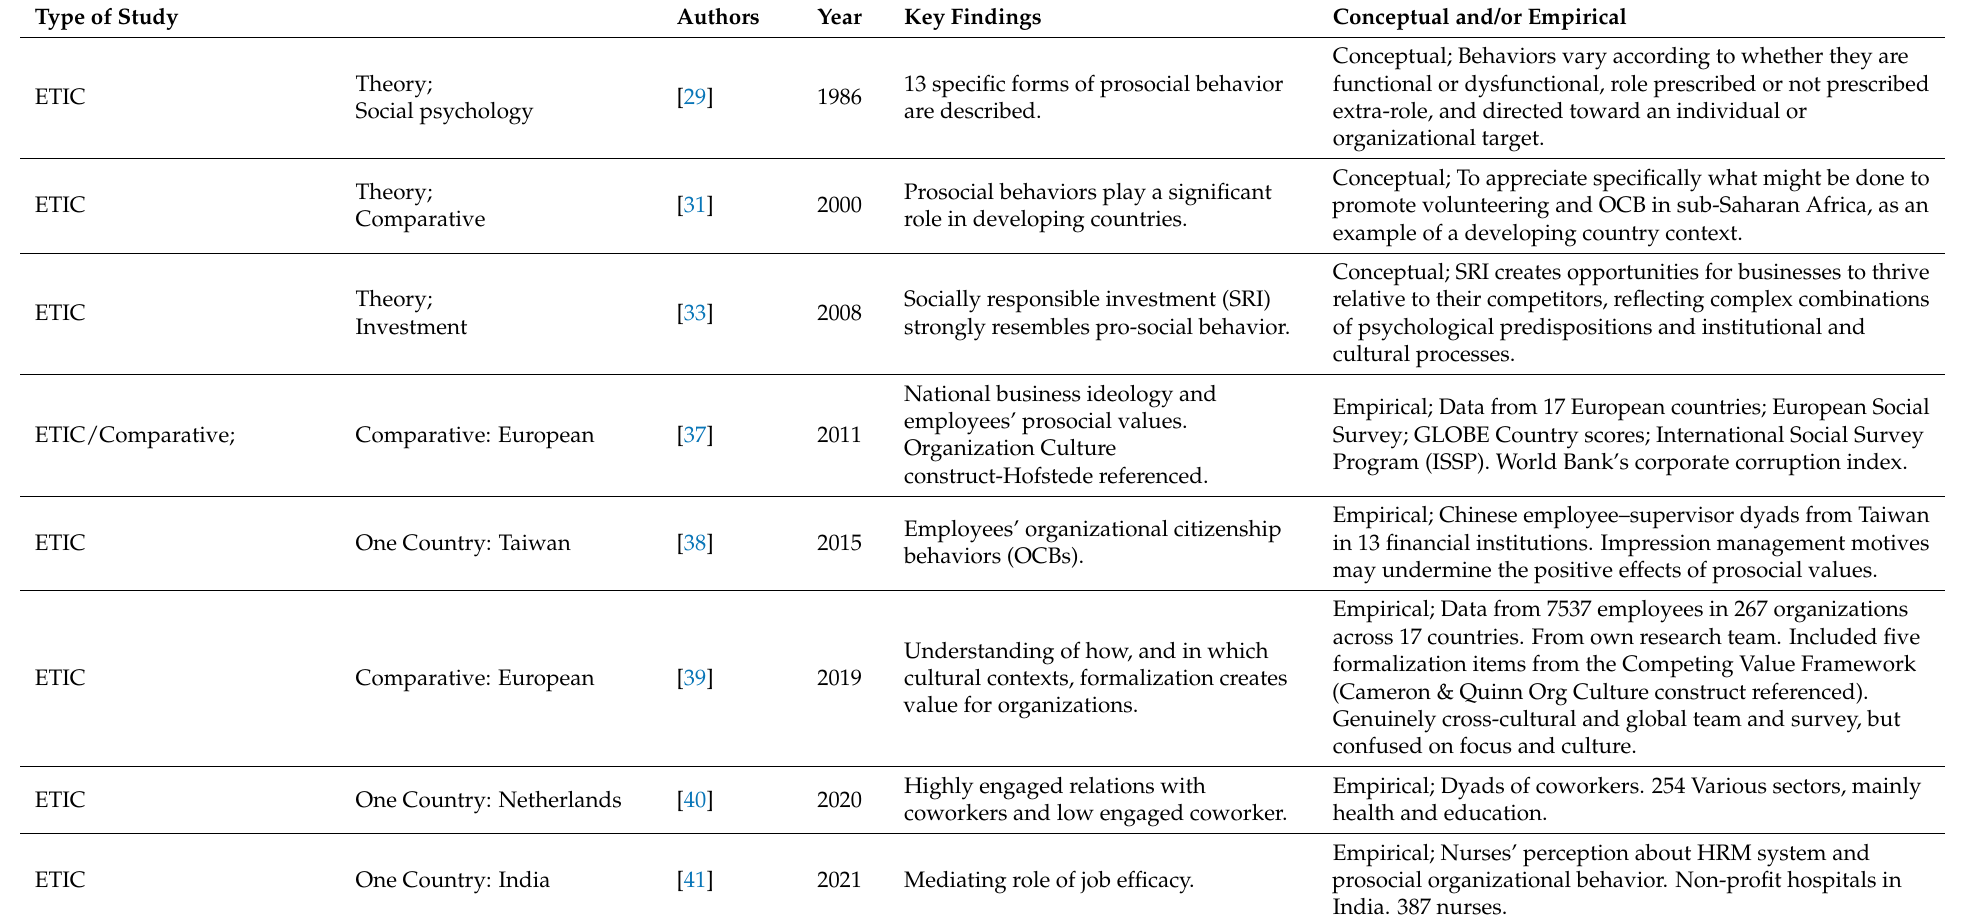
Table 1. Literature Review